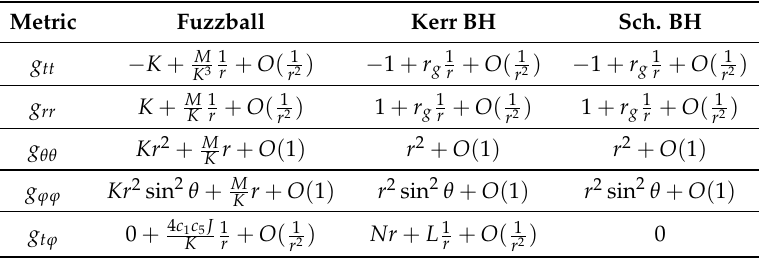
Table 1. Asymptotical behavior of